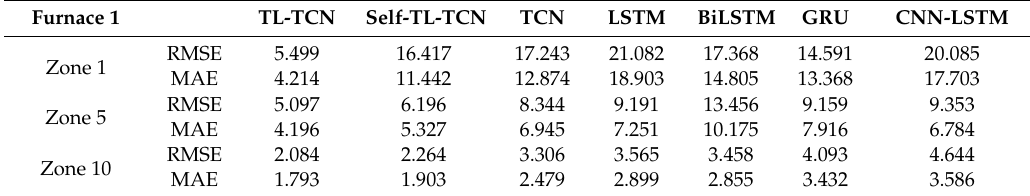
Table 18. Knowledge transfer between the same equipment at di ff erent times.